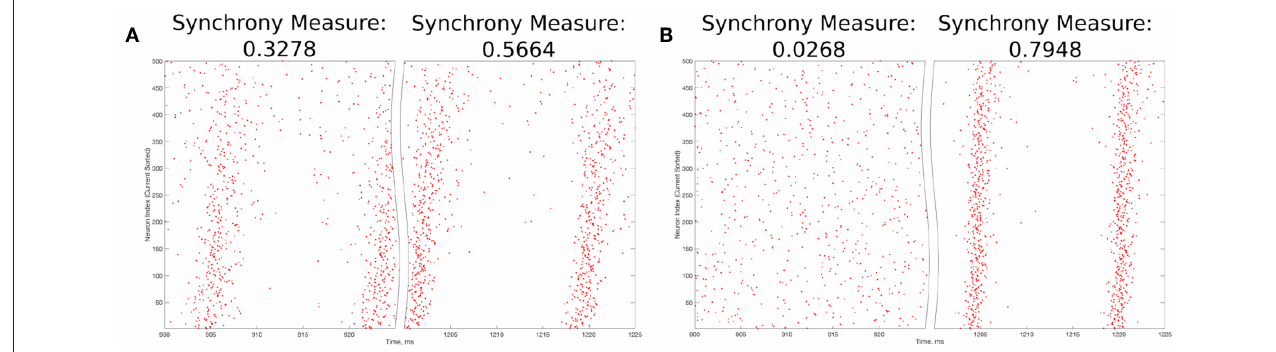
FIGURE 3 | Example raster plots illustrating the Synchrony Measure and motivating the definition of the Bistability Measure. (A) An example network that exhibits “weak” synchronous dynamics both before and after the perturbation is delivered at 1,000 ms, resulting in a moderate value of the Synchrony Measure in each case. Dynamics before the perturbation are shown in the left panel, while dynamics following the perturbation are shown in the right. Although the Synchrony Measure following the perturbation is larger than that before the perturbation, this increase does not indicate a bistable transition from asynchronous to synchronous dynamics, but rather qualitatively “tighter” synchrony. The choice of 0.3 as the “threshold value” in the articulation of the Bistability Measure prevents cases such as this from contributing positively to the measure. (B) An example network exhibiting asynchrony before the perturbation (left panel) and very clear synchrony afterwards (right panel), along with the corresponding Synchrony Measures. Very low synchrony measures (typically < 0.25) indicate asynchrony, while higher Synchrony Measures illustrate synchrony, with higher values indicating more structured, “tighter”